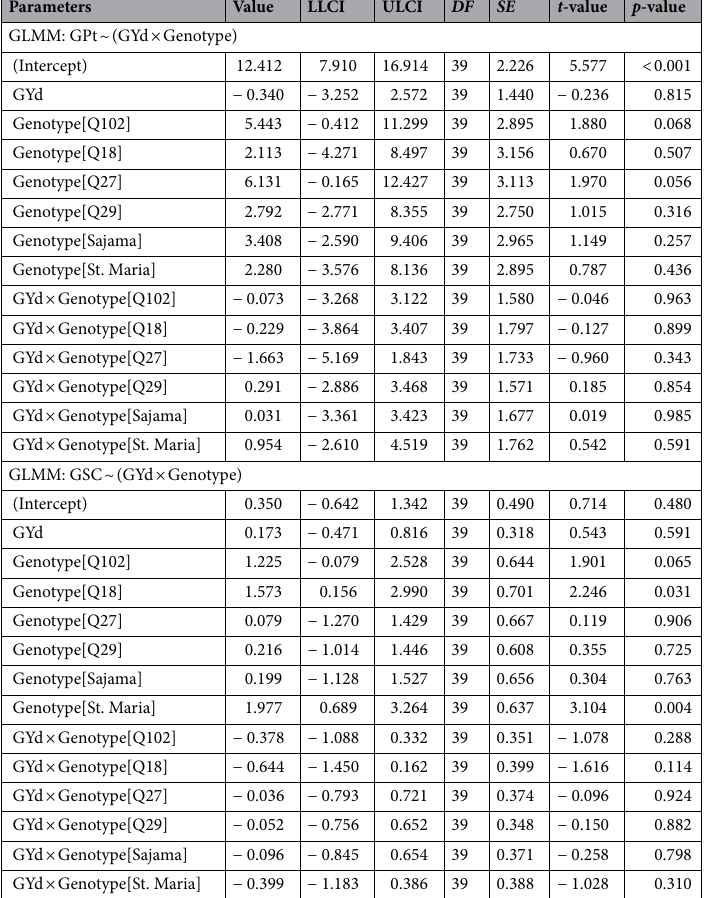
Table 6. Parameters of GLMMs testing the effect of grain yield (GYd) on grain proteins (GPt) and grain saponin content (GSC) for different quinoa genotypes cultivated in open field under hot-arid conditions. DF : degrees of freedom, LLCI and ULCI: lower and upper limit of the confidence interval,